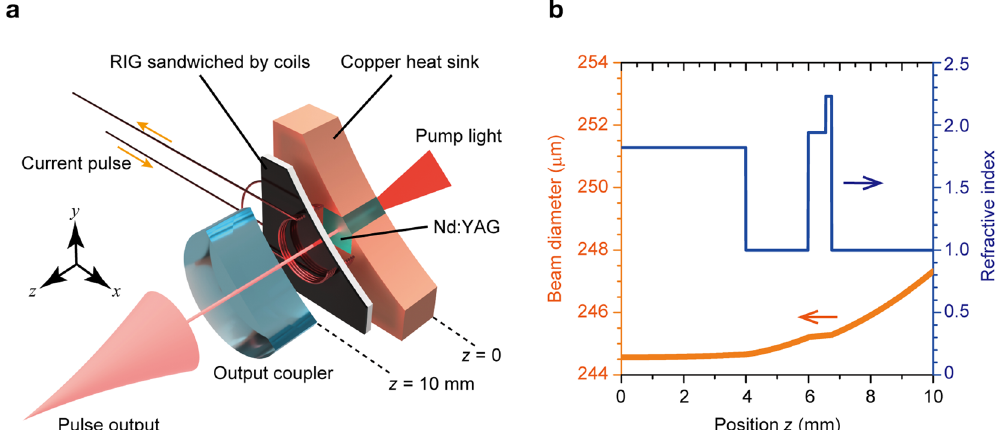
Figure 1. Diode-pumped magnetooptical (MO) Q-switched laser. ( a ) Schematic of laser cavity setup. The rare- earth substituted iron garnet (RIG) film was sandwiched by a pair of coils and its magnetisation was modulated by a pulsed field. The minimum cavity length L was 10 mm. ( b ) Beam diameter (thick orange line) estimated using ABCD matrix method and refractive indexes (thin blue line) in